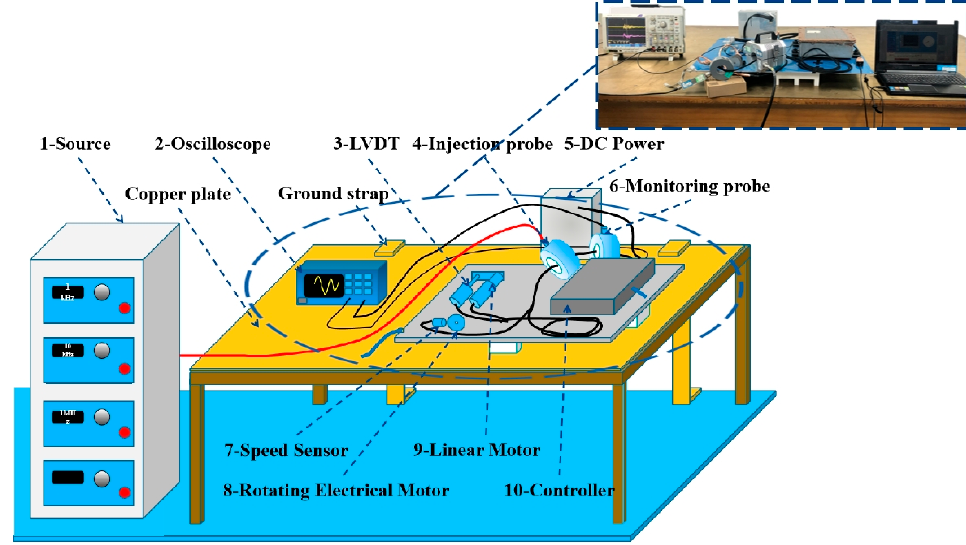
Table 1. Bulk current injection test equipment.